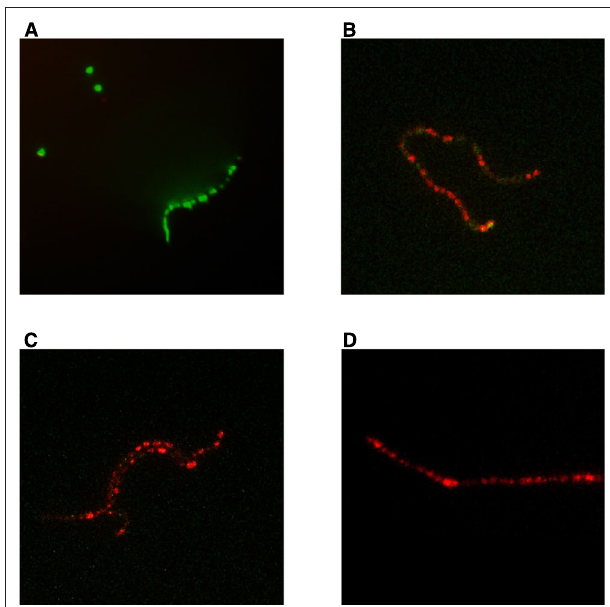
FIGURE 1 | Bactericidal action of capsaicin against strain SP1070. Live/dead assay: (A) control, no capsaicin; (B) 15 min incubation, (C) 30 min incubation, and (D) 60 min incubation in presence of capsaicin MIC (128 m g/mL). Bacteria with intact cell membranes stain fluorescent green, those with damaged membranes stain fluorescent